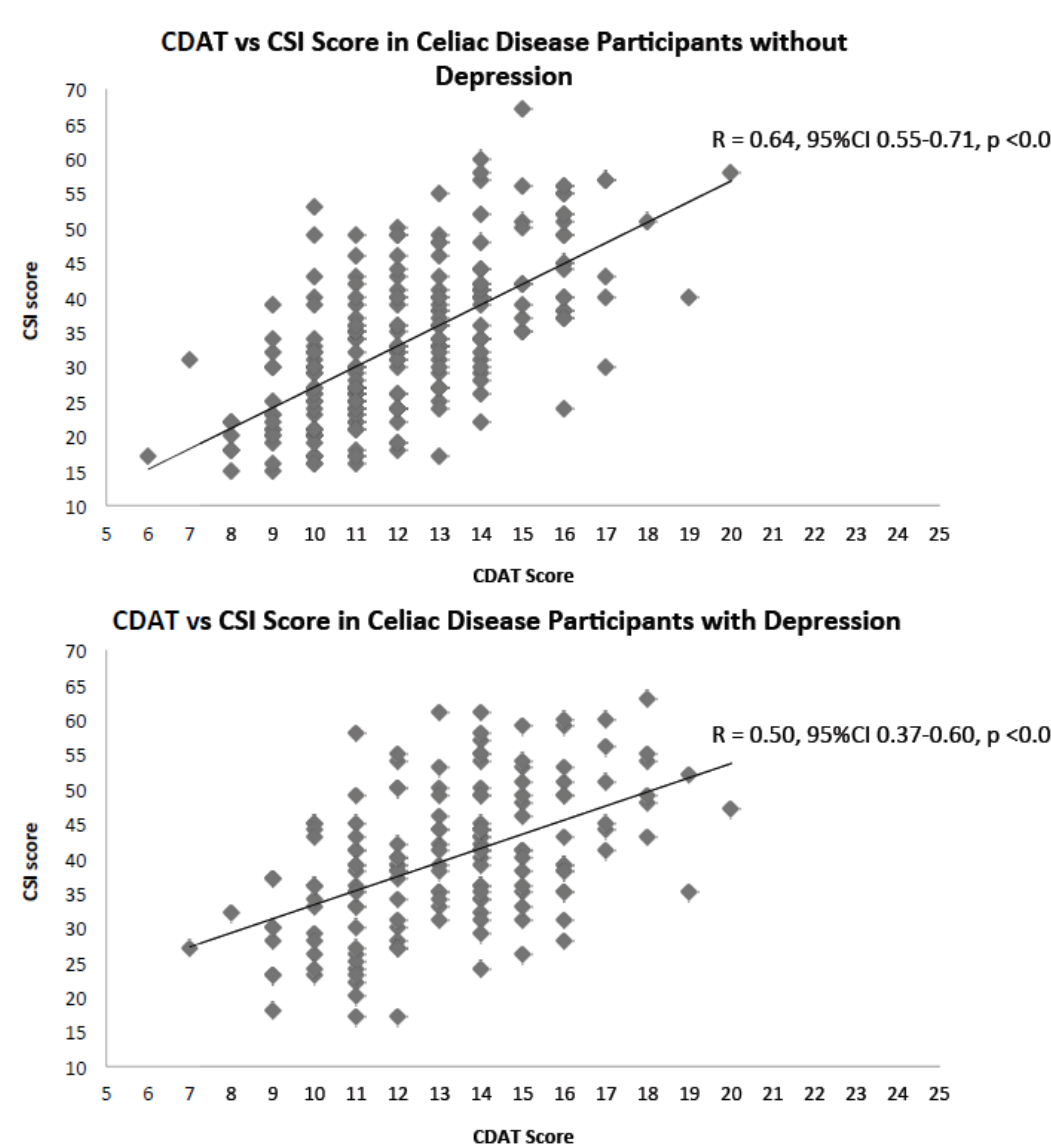
Figure 1. Celiac Dietary Adherence Test vs. Celiac Symptom Index Scores in patients with depressive symptoms versus those without depressive symptoms.